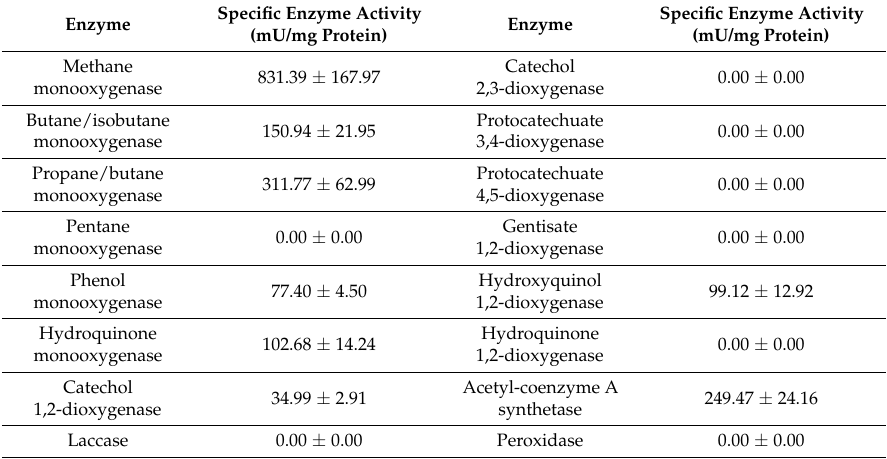
Table 2. Specific activity of enzymes after ibuprofen